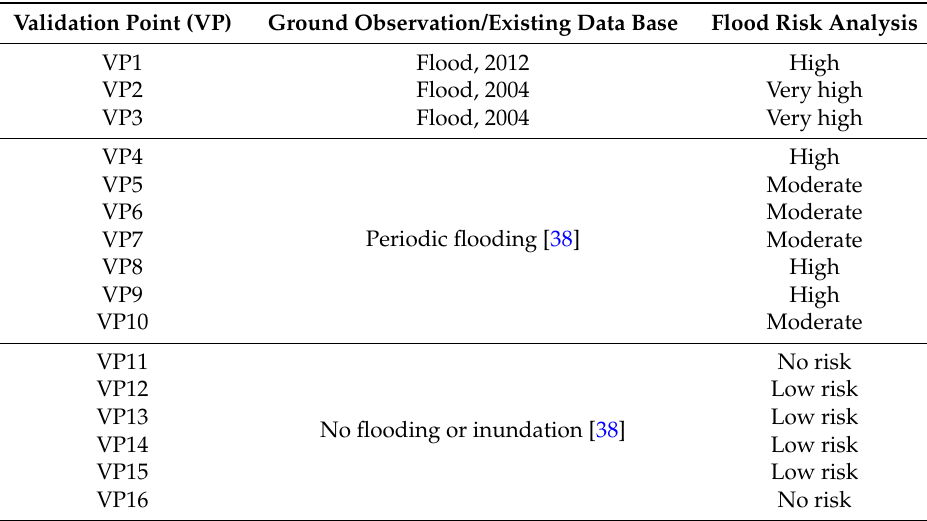
Table 6. Validation of flood risk map through